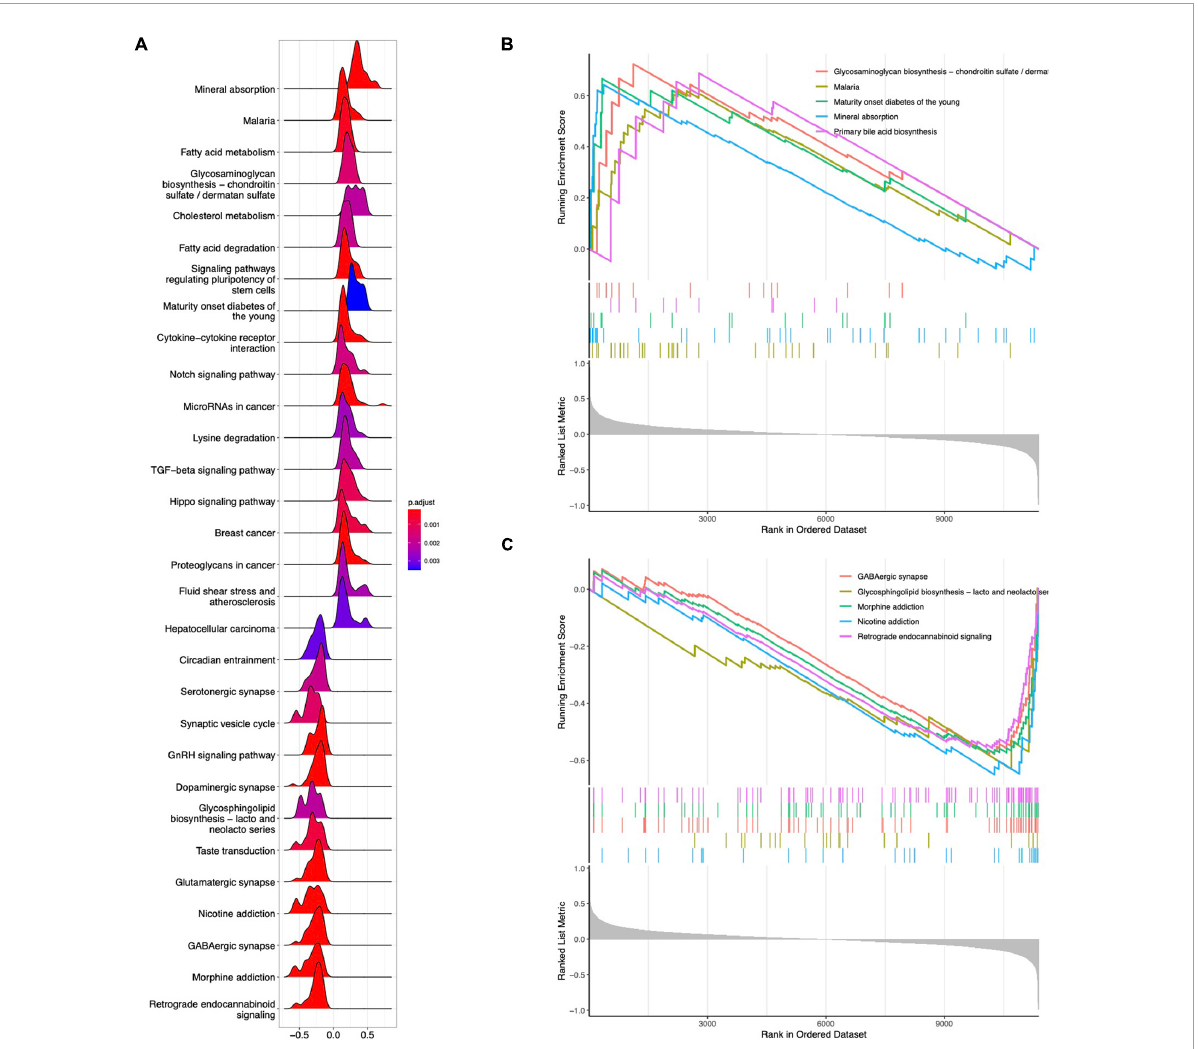
FIGURE4 GSEA analysis for DEGs. (A) Ridgeline plot of GSEA analysis results. (B) Top five enrichment terms for upregulated DEGs. (C) Top five enrichment terms for downregulated